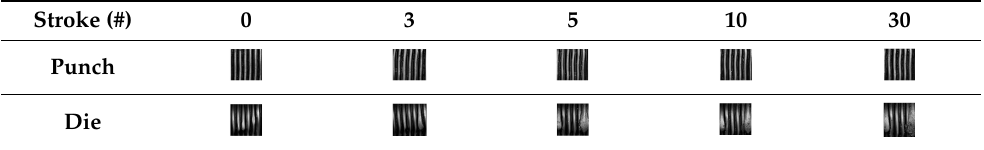
Table 3. Images of tool surfaces for different numbers of strokes that have been performed. Each figure shows an area that is 600 µ m by 600 µ m.